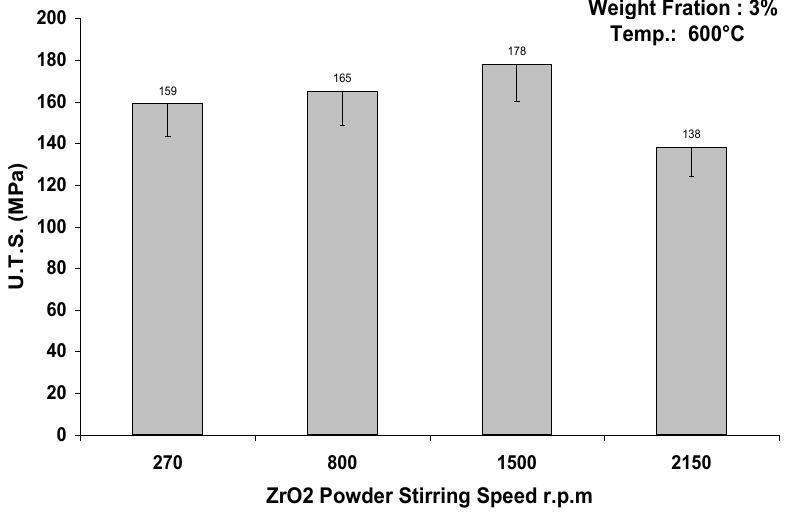
Figure 7. The effect of stirring speed on the UTS of 3 weight% ZrO 2 nanoreinforced alloy at 600